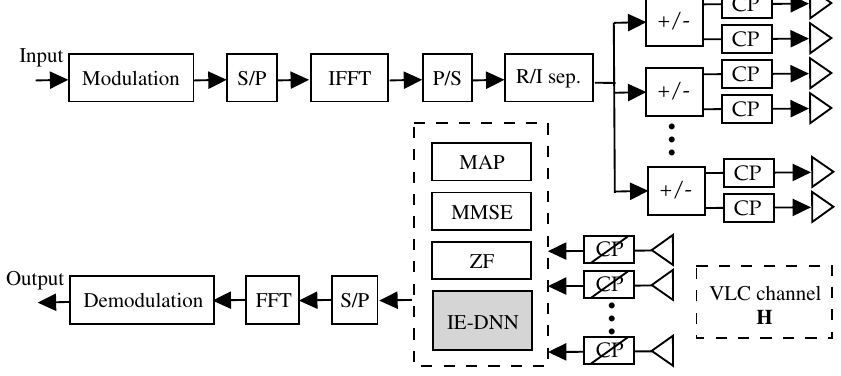
Figure 1. System model with proposed